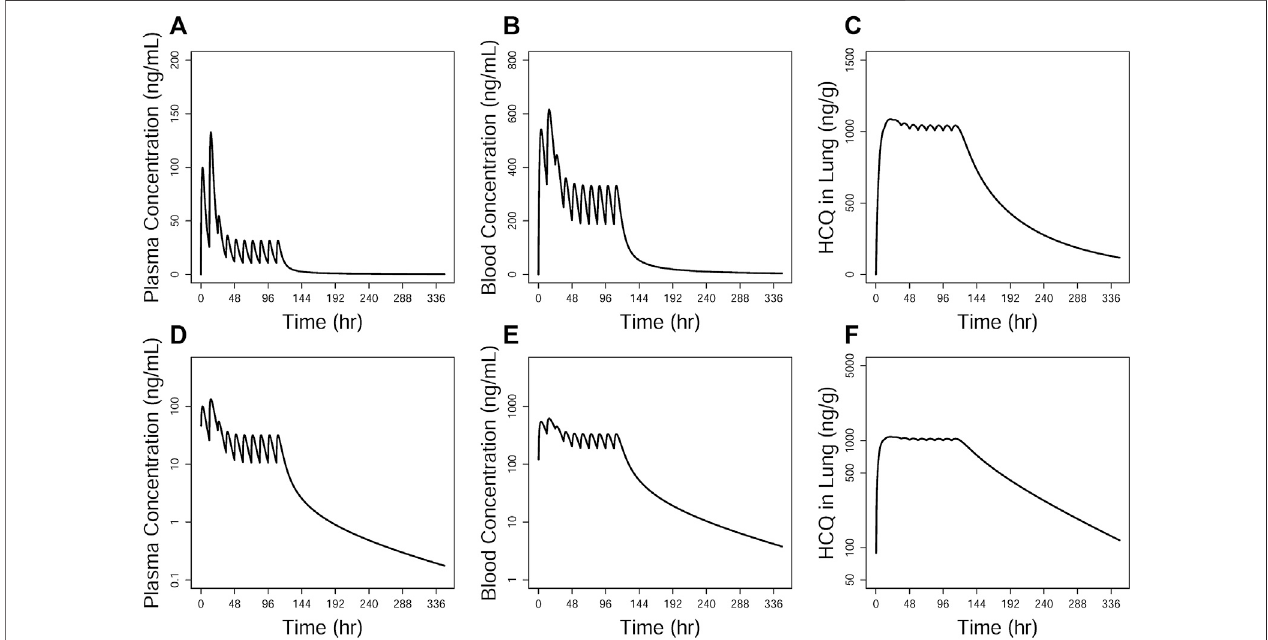
FIGURE 9 | Simulations of HCQ pharmacokinetic pro fi les in the plasma (A and D) , blood (B and E) , and lung tissue (C and F) , respectively. The upper row is constant coordinate plots and the lower row semi-log ones.